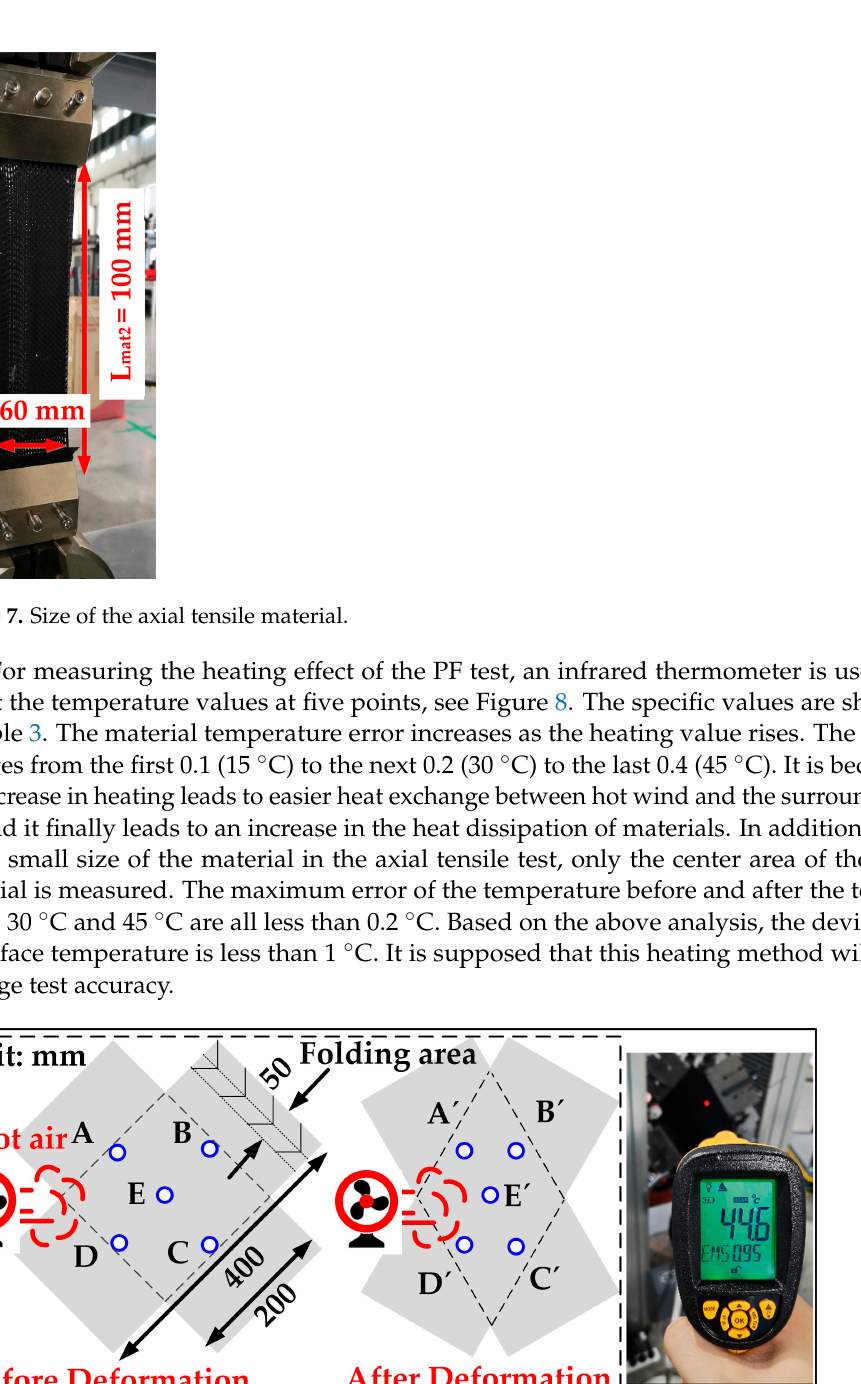
Figure 6. Picture of the PF test device.